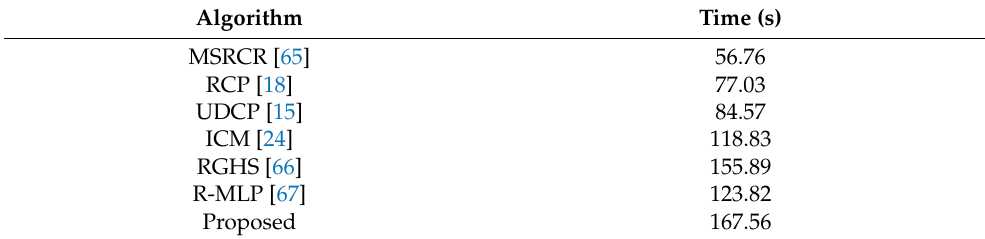
Table 1. Execution speed by using different algorithms.